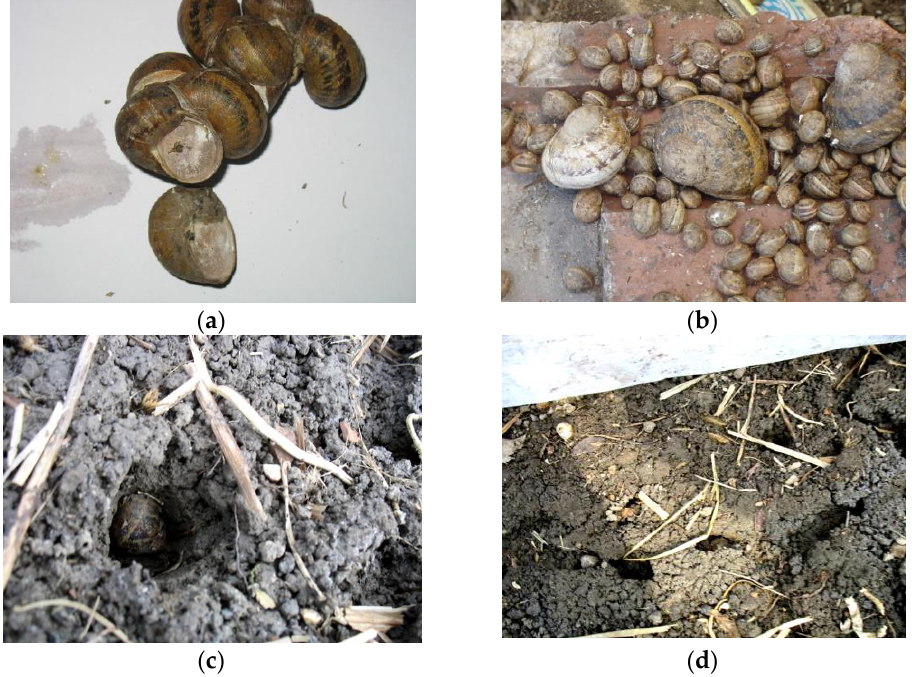
Figure 4. Selected behavioral aspects of overwintering C. aspersum ( a ) Overwinteringgregariousness in C. aspersum . ( b ) Adult and juvenile gastropods overwintering attached on the lower surface of ridge tiles. ( c ) Adult snail, C. aspersum , burrowed into the upper topsoil layer. ( d ) Network of tunnels dug by mature gastropods.